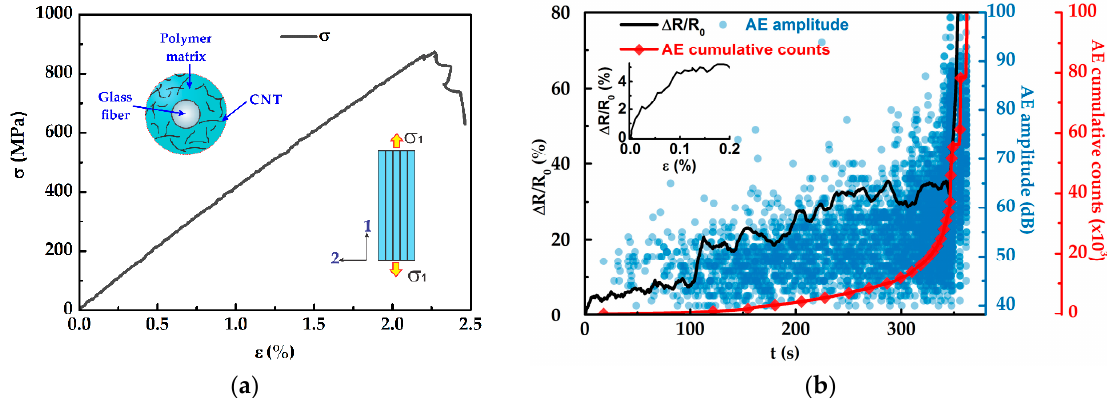
Figure 4. Mechanical, electromechanical, and acoustic emission characterization of the composite with architecture m . ( a ) Stress-strain curve, ( b ) evolution of ∆ R/R 0 (continuous line), AE amplitude (circles), and AE cumulative counts (diamonds) during the tensile test.